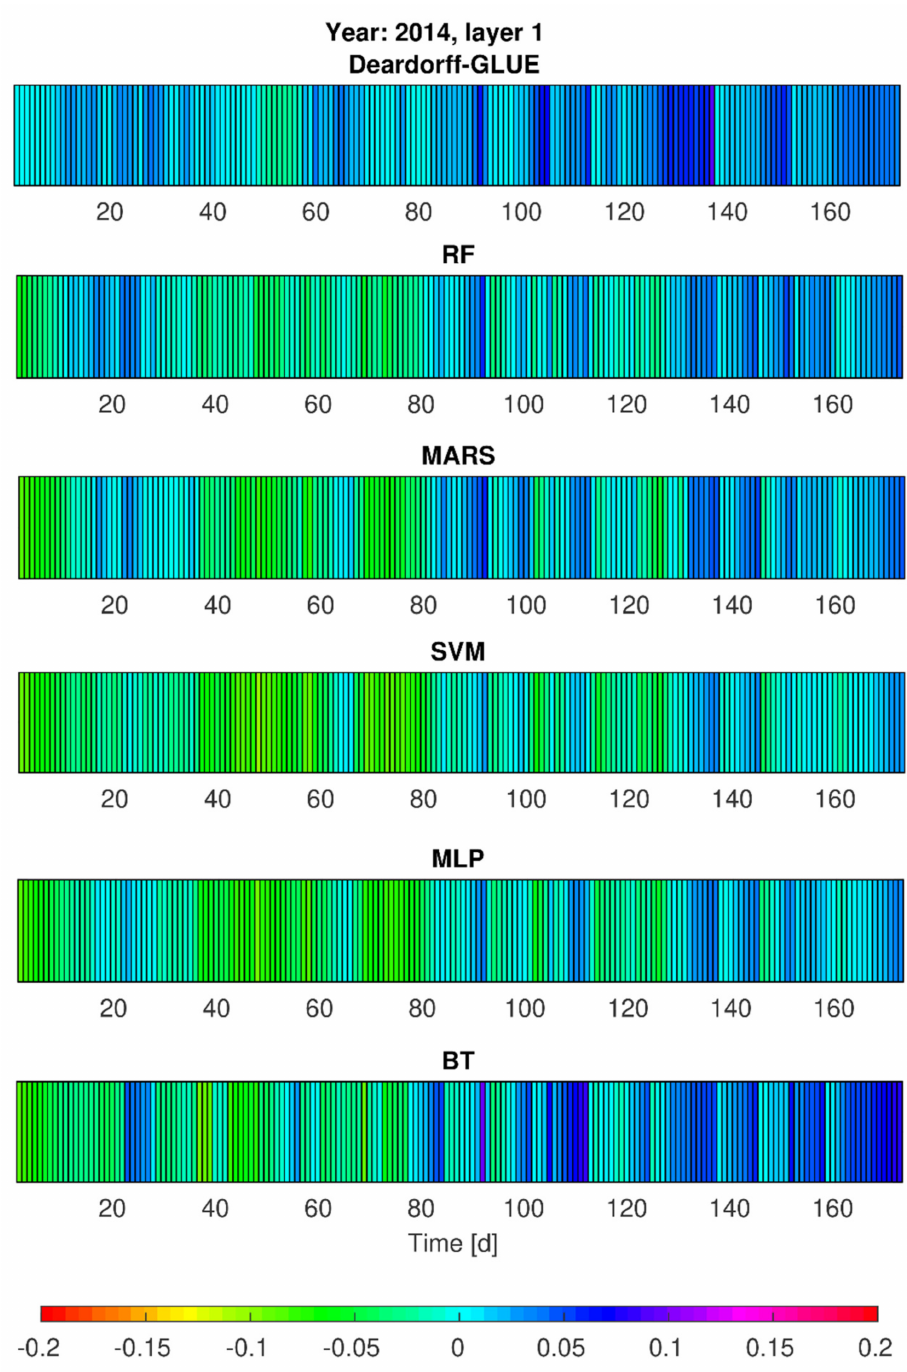
Figure 9. Error variability of the soil moisture content w 1 (first layer) for 2014 by Deardorff model and statistical methods (BT, RF, SVM, MLP,